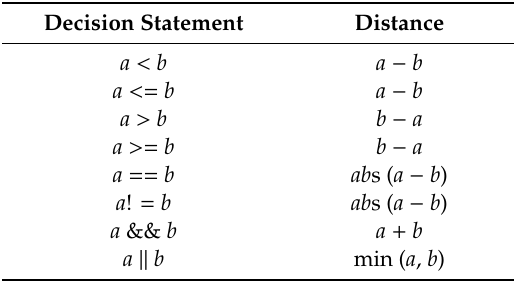
Table 1. The calculation of